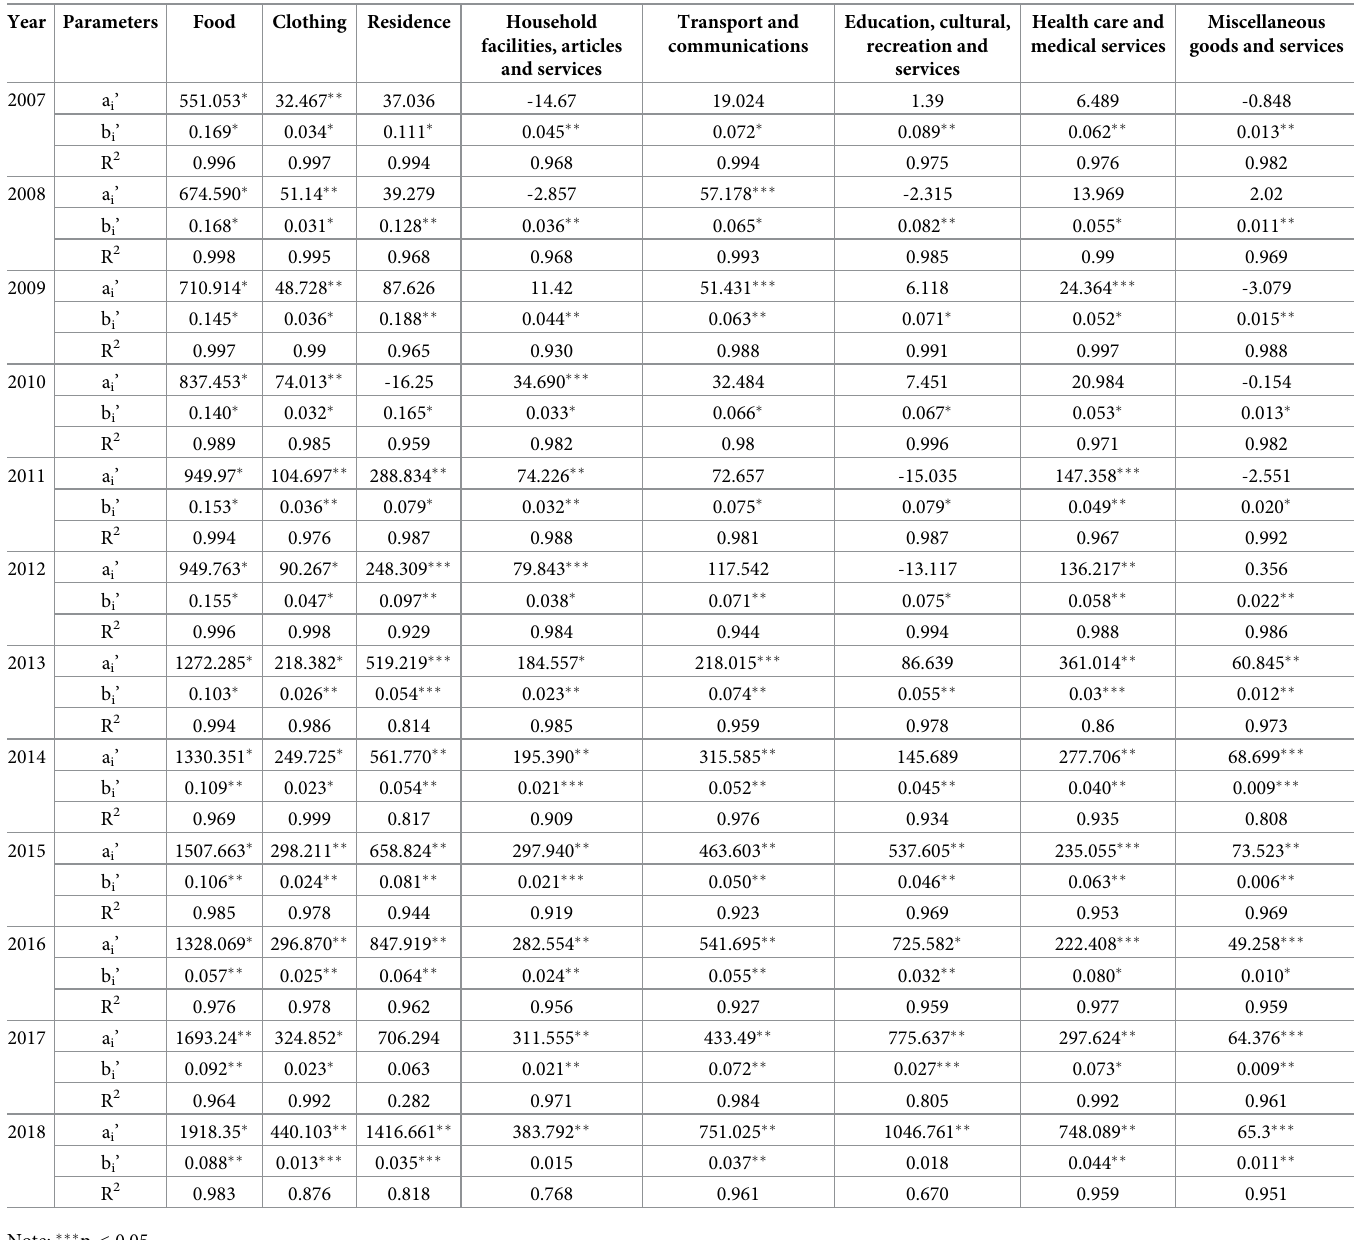
Table 3. Parameter estimation of the ELES